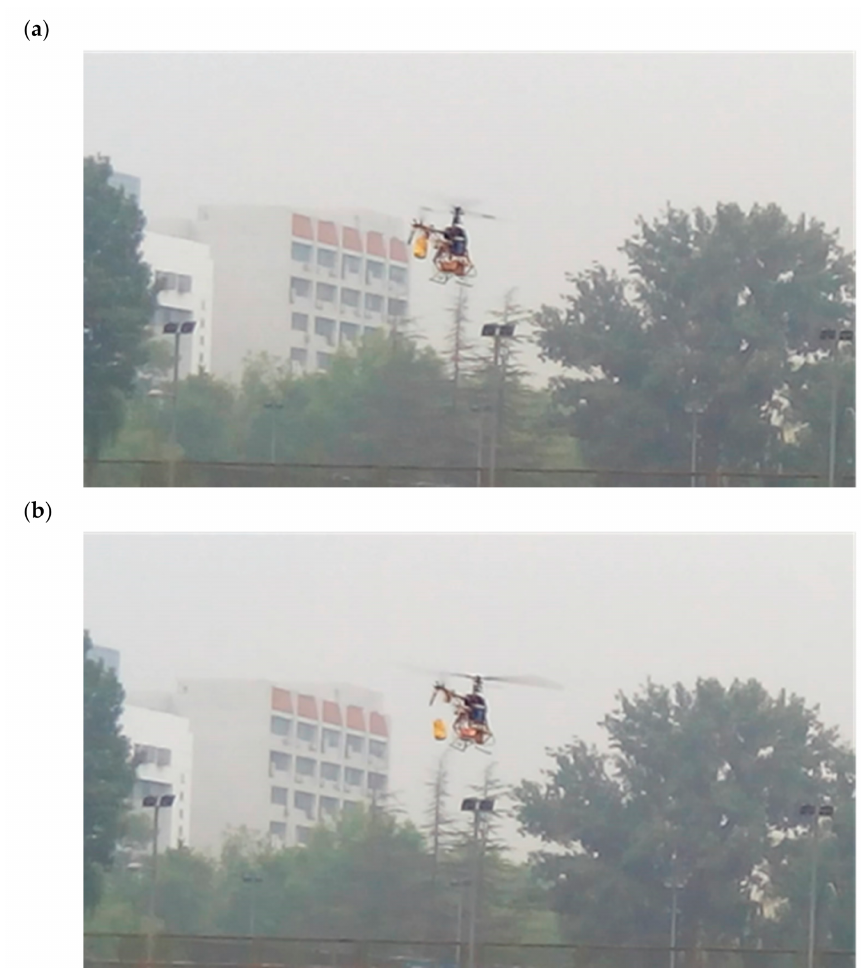
Figure 8. The block dropping procedure of the experiment. ( a ) Hovering before dropping the block; ( b ) the moment after dropping the